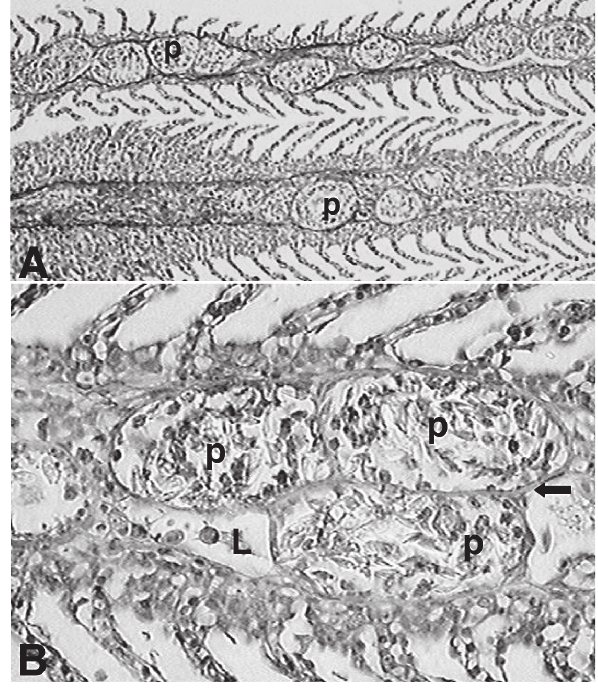
Fig. 3. – Histological sections of several organs infected by Myxobolus cuneus n. sp. A - longitudinal section of fin showing a plasmodium (p) in connec- tive tissue between the rays (r). H & E staining. 200 × . B - transversal sec- tion of operculum showing a plasmo- dium (p) deep within the subcuta- neous tissue, near the periosteum (arrow). Sirius red staining. 200 × . C - sections of urinary bladder showing plasmodia (p) in the subepithelial connective tissue and in the middle layer (*). H & E staining. 260 × . D - section of gall bladder showing a plas- modium (p) in the serous capsule. Sirius red staining. 700 ×